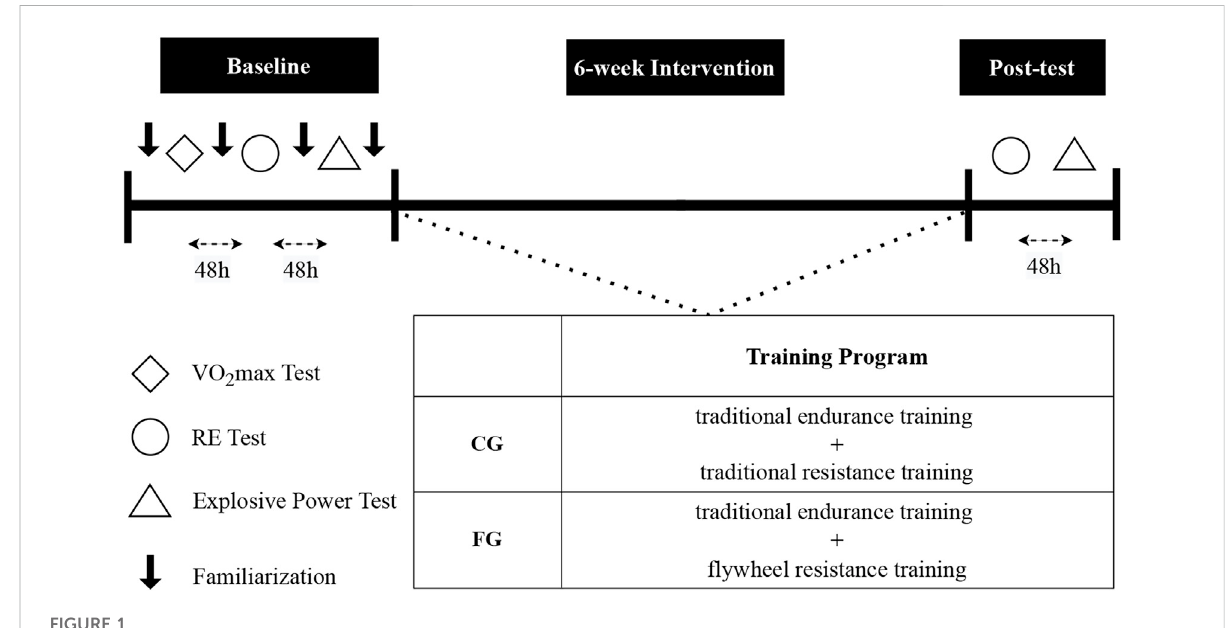
FIGURE 1 Schematic diagram of the experimental process.